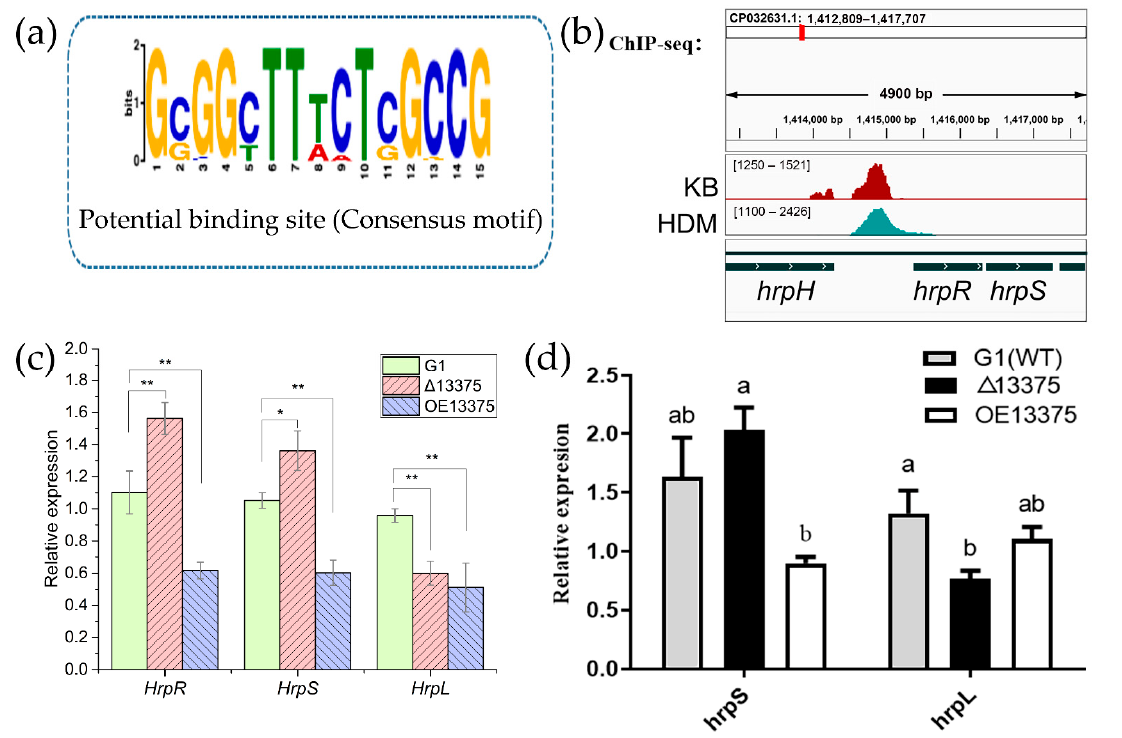
Figure 3. OmpR-like is a negative regulator of the hrpR/S gene. ( a ) The most significant motif iden- tified by ChIP-seq using the MEME tool; ( b ) original sequence peaks show the OmpR-like-binding regions in the hrpR/S promoter; ( c ) the transcription levels of hrpR , hrpS , and hrpL in G1, Δ 13375, and OE13375 were detected by RNA-seq; ( d ) the relative expressions of hrpS and hrpL in G1, Δ 13375, and OE13375 were verified by qRT-PCR. G1: wild-type strain; Δ 13375: OmpR-like deletion mutant; OE13375: OmpR-like overexpression mutant. For two-sample comparison in ( c ), the Student’s t test was used (*, p < 0.05; **, p < 0.01); and different lowercase letters in ( d ) indicate significant differences at p < 0.05 level as determined by least significant difference (LSD) tests for multiple comparisons.